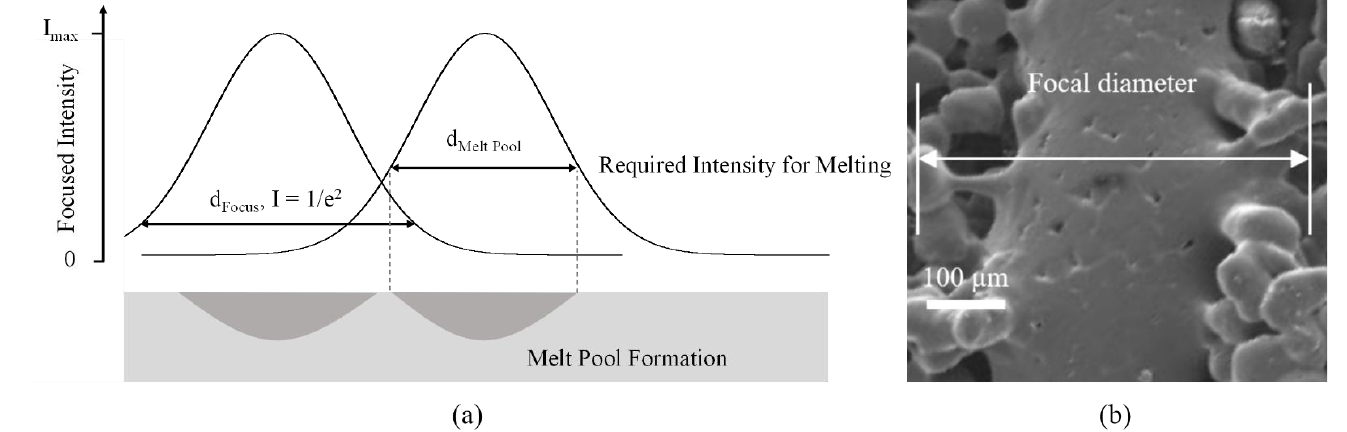
Figure 8. ( a ) Schematic depiction of the influence of the Gaussian laser intensity distribution on the intensity-dependent discretization of distinct melt pools during the initial exposure step; and ( b ) corresponding exemplary scanning electron micrographs, depicting the sub-focus formation of recrystallized melt pools and nearby adhering powder particles during the initial exposure cycle, P Laser = 16 W.